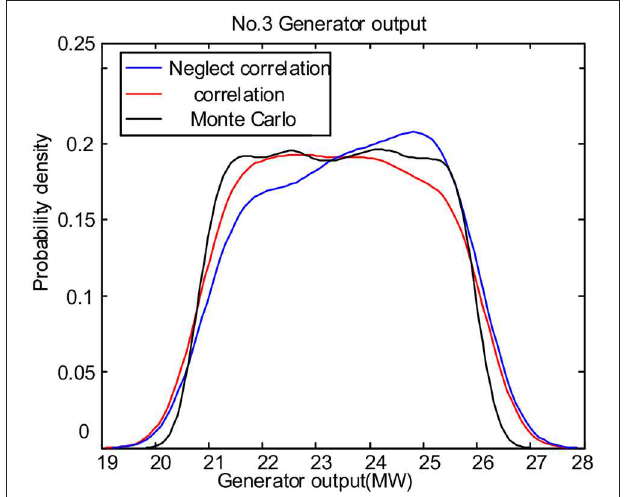
FIGURE 8 | Probability density of No. 3 generator output.